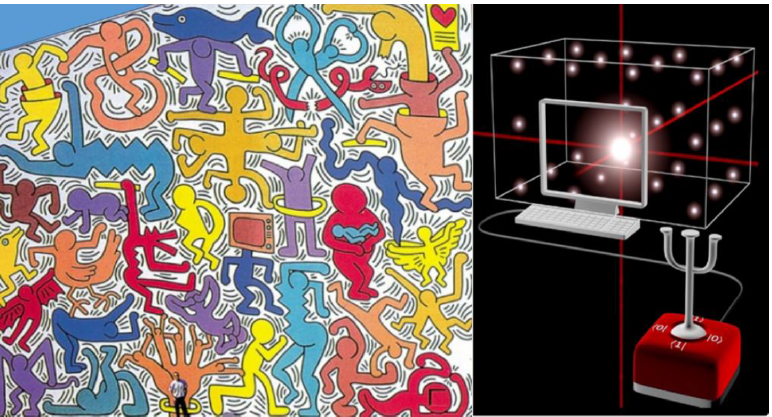
Figure 1. IQHuMinds concept of Quantum Black Box. Creativity and intuition from players’ crowd, here represented by Keith Haring’s artwork “Tuttomondo” in Pisa, are interfaced with the Computer machine via a video game, represented by the psi-joystick, to solve a quantum